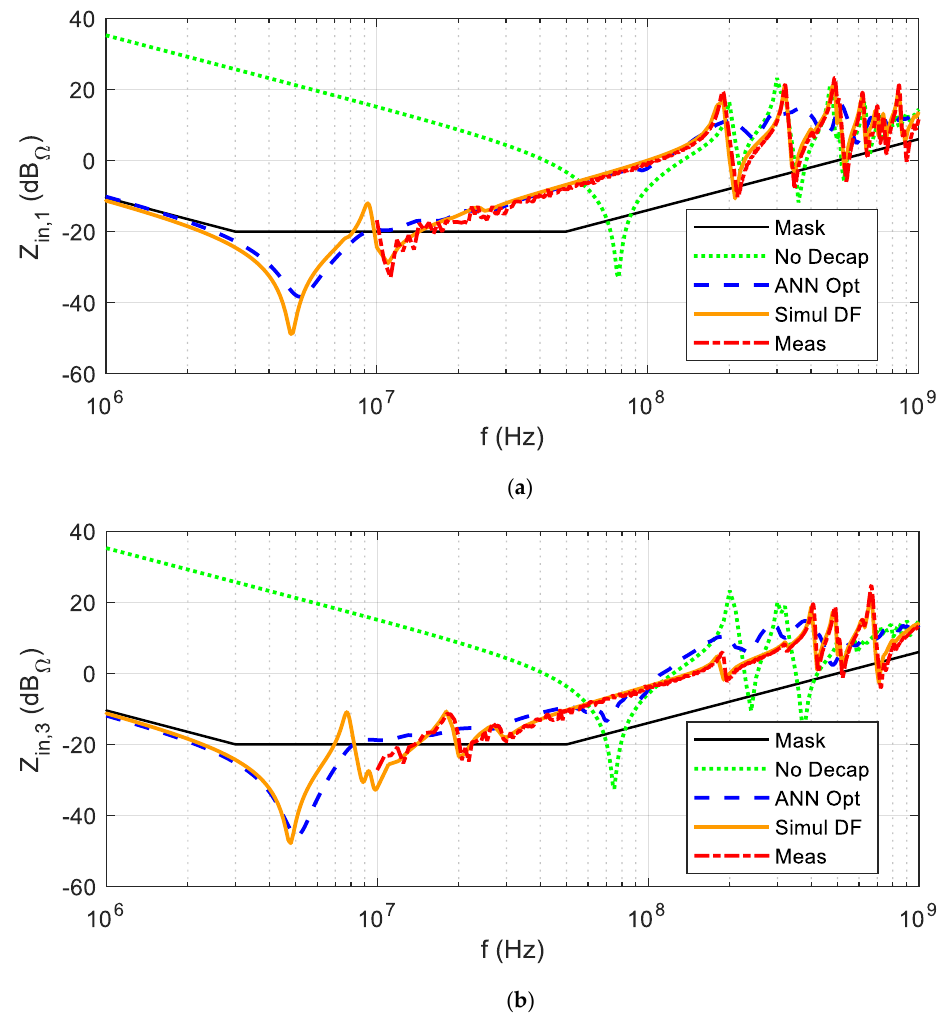
Figure 14. Input impedances at ports 1 ( a ) and 3 ( b ). Comparisons among the impedances measured, simulated by DF, and predicted by the ANN.